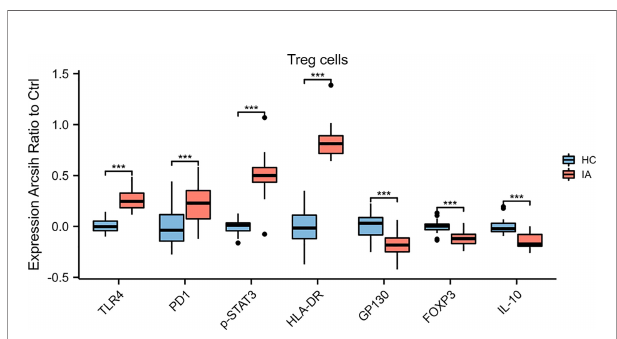
FIGURE 4 | Marker expressions in Treg cells. The expression levels of TLR4, PD1, p-STAT3, and HLA-DR in Treg cells were higher, while those of GP130, Foxp3, and IL-10 were lower, in IA patients compared with HCs. P values were calculated by the two-sided Wilcoxon test. Signi fi cance: ***p <